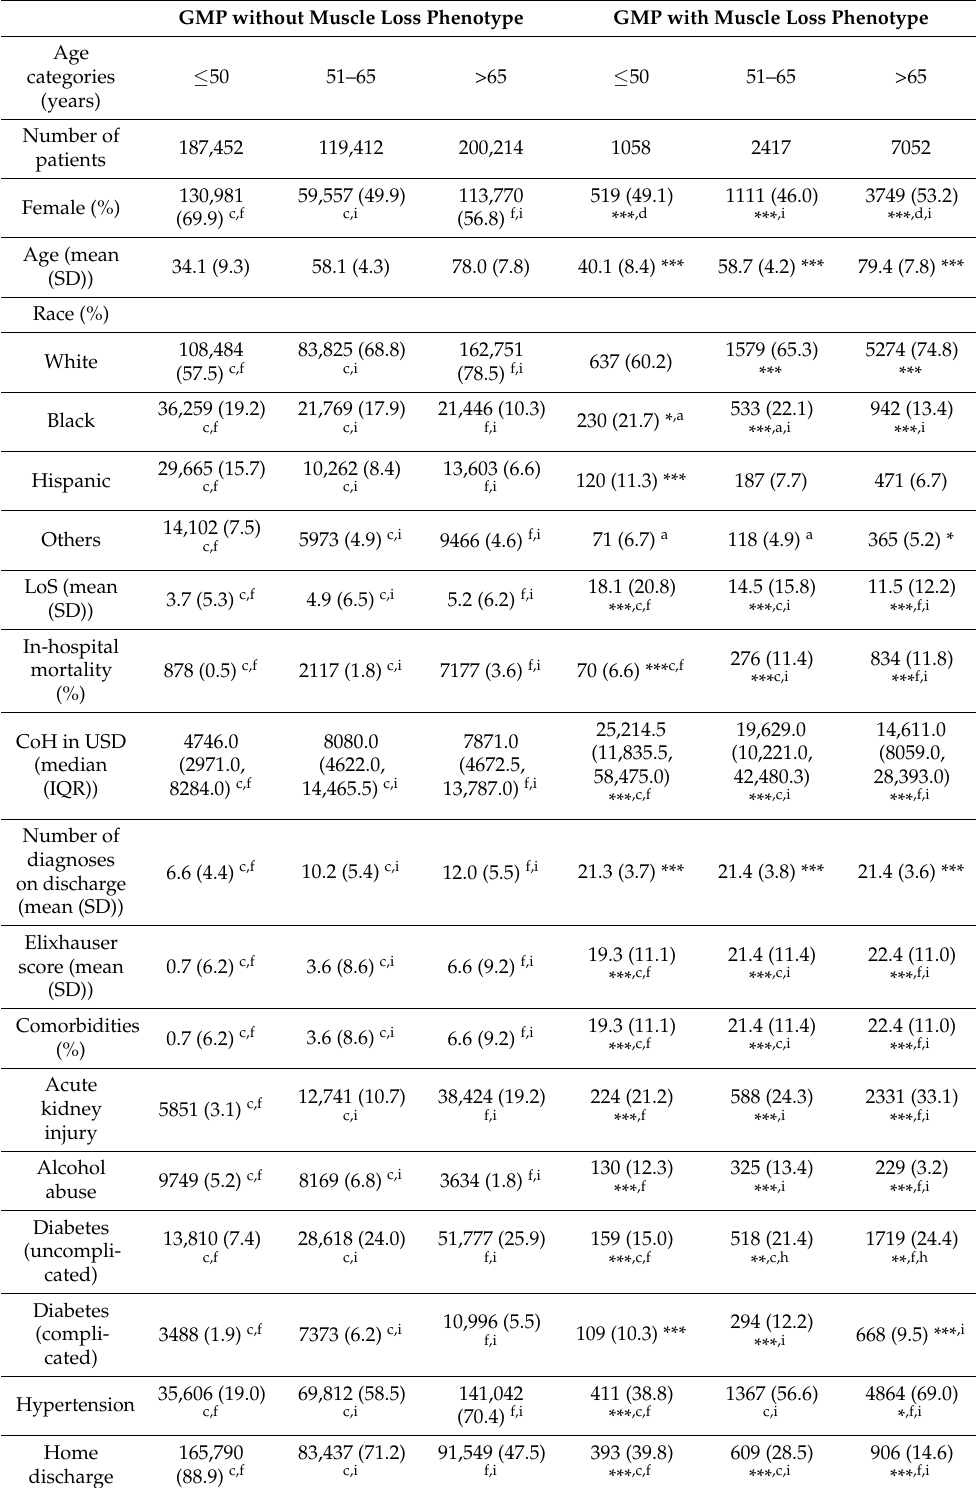
Table 4. Demographic characteristics of hospitalized general medicine patients with/without muscle loss phenotype grouped by